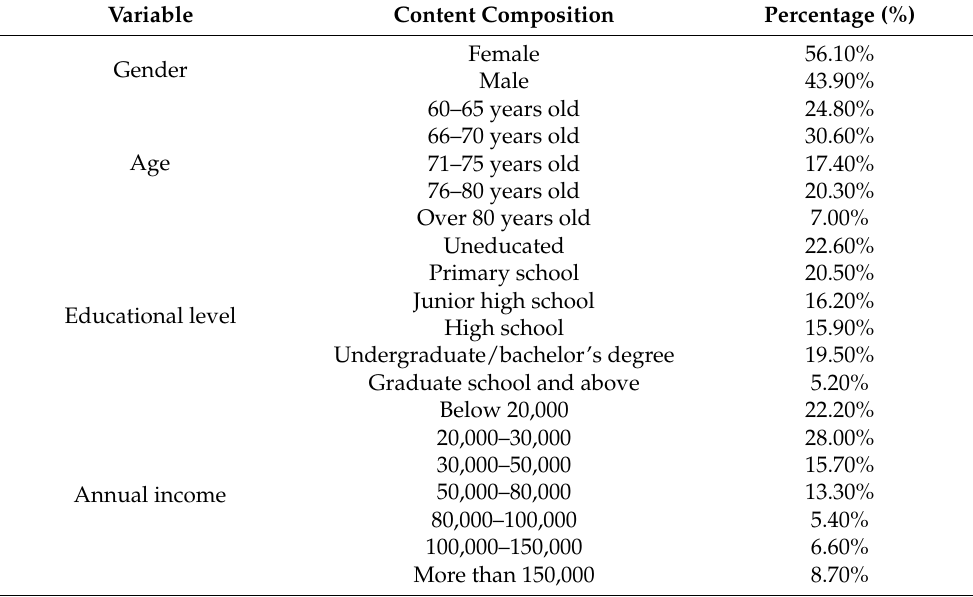
Table 2. Descriptive statistics of the sample population